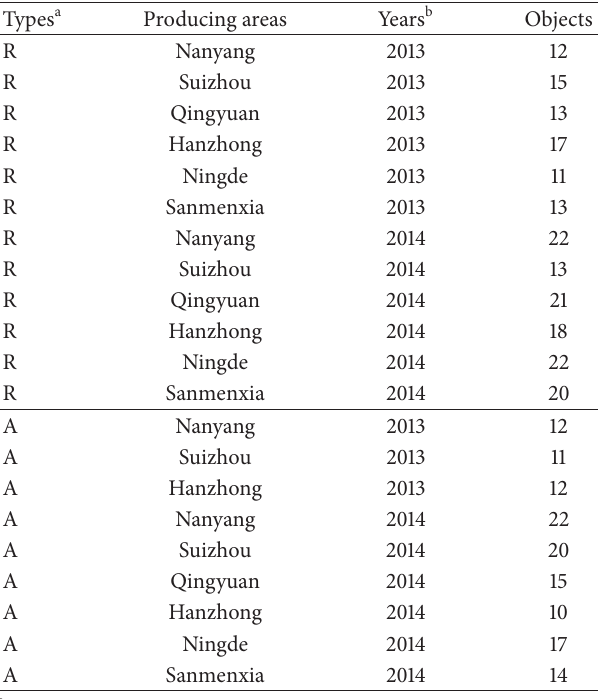
Table 1: Origins and types of shiitake